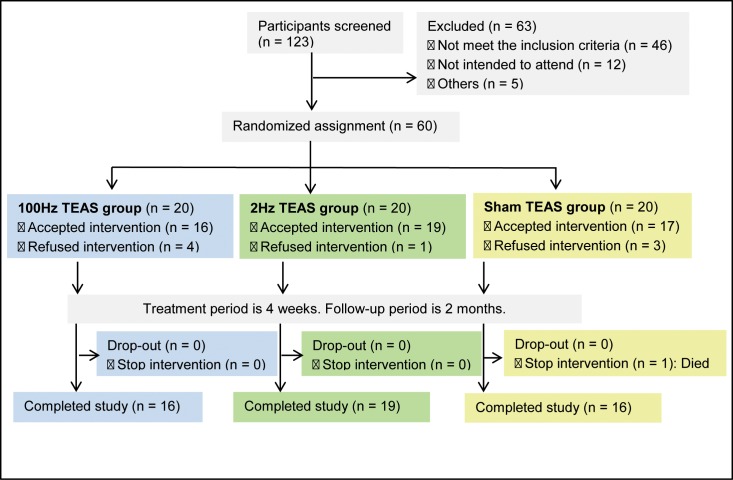
The CONSORT flow diagram.